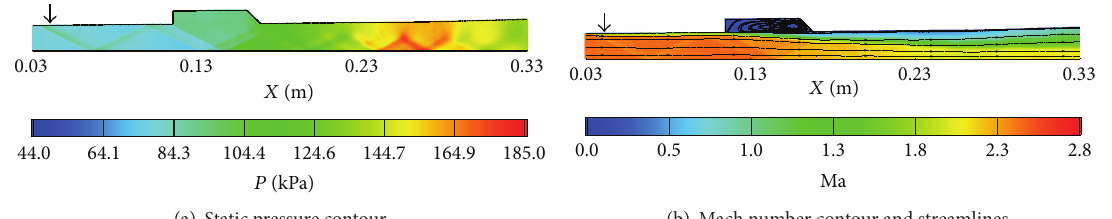
Figure 4: Detailed flow field for Case 1.